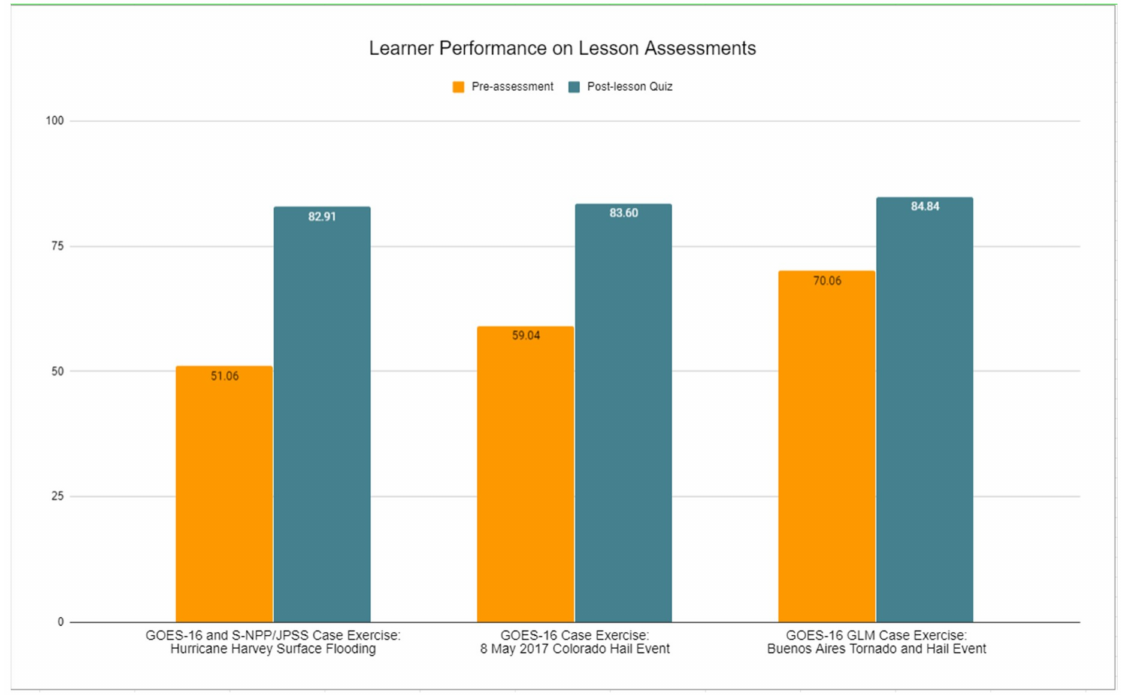
Figure 15. The bar graph displays the mean pre-assessment and post-lesson quiz performance (average percent out of 100) of learners who took both assessments for each of three case exercise